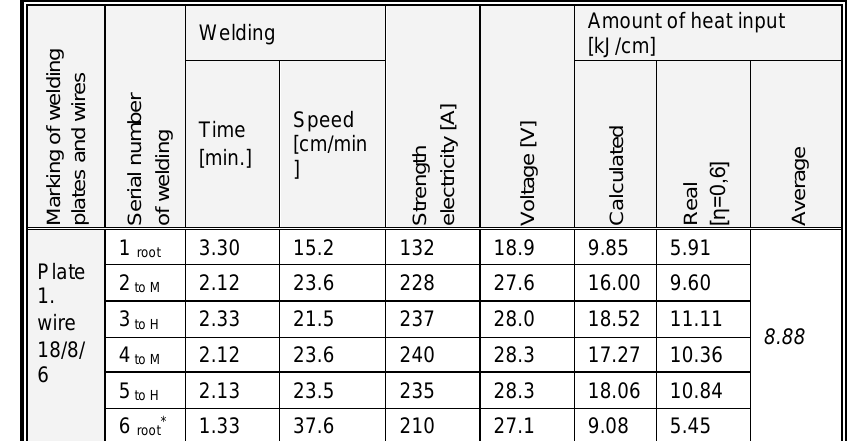
Table 5 – Passages when welding plate 1 with the amounts of heat